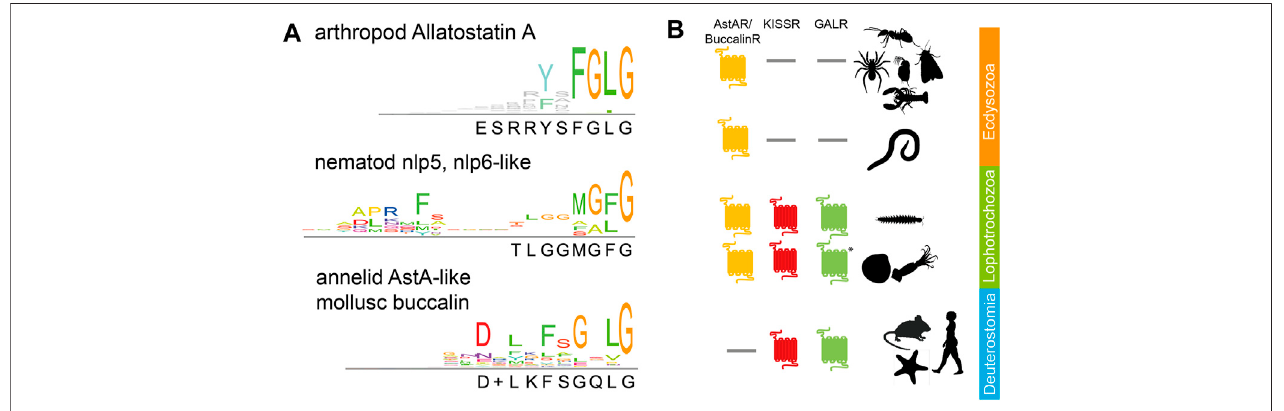
FIGURE 1| Phylogeny of AstA signalling: (A) Consensus sequences for AstA and similarpeptidesin arthropods(top), nematodes (middle), and lophotrochozoans (annelids, molluscs, bottom). The C-terminal glycine indicates the amidation site. Sequences are given in Supplementary Material 1; (B) While AstA-Rs are found throughout theprotostomes,KISSRs, and GALRs have been lostin theEcdysozoa[incl.Nematodaand Panarthropoda (Felixetal.,2015;Li et al.,2021)]. *= GALR-like receptors have only been found in cephalopods. Pictogrammes from